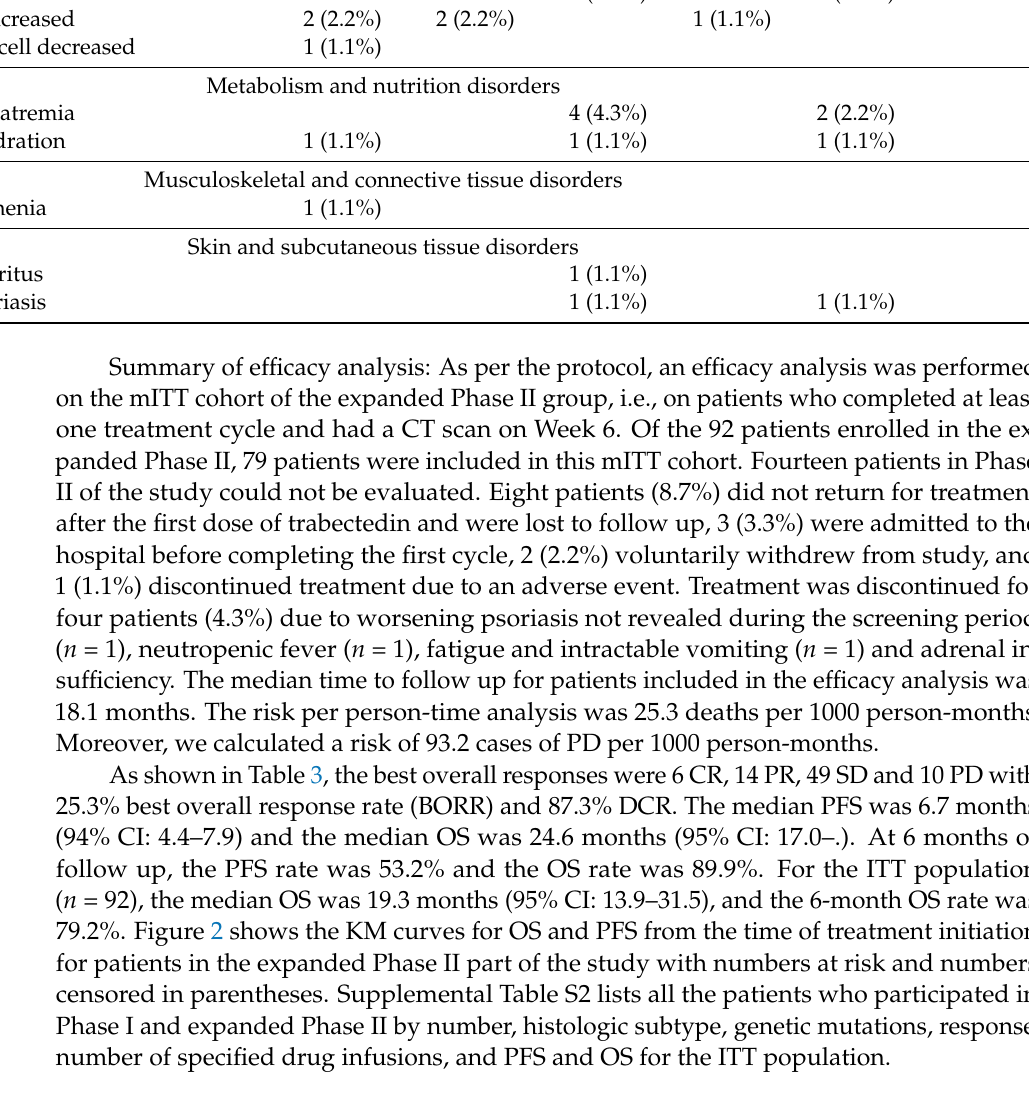
Table 3. Expanded Phase II: Responses to treatment for the mITT population ( n =